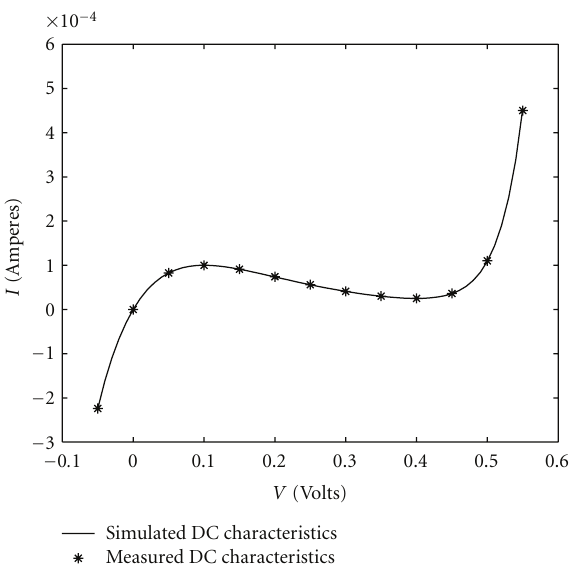
Figure 9: Simulated I - V characteristics of the Esaki tunnel diode compared with measurement.